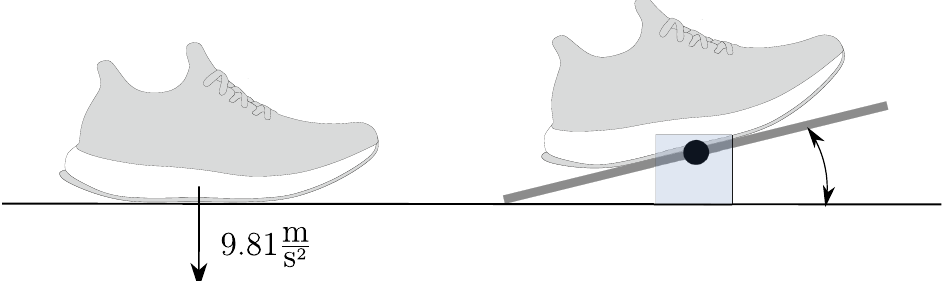
Figure 4. Visualization of the functional calibration procedure. The first part of the functional calibration consisted of standing still with the foot flat on the ground in order to measure gravity. During the second part the subjects rotated their feet on a balance board to compute the medial/lateral axis using a principal component